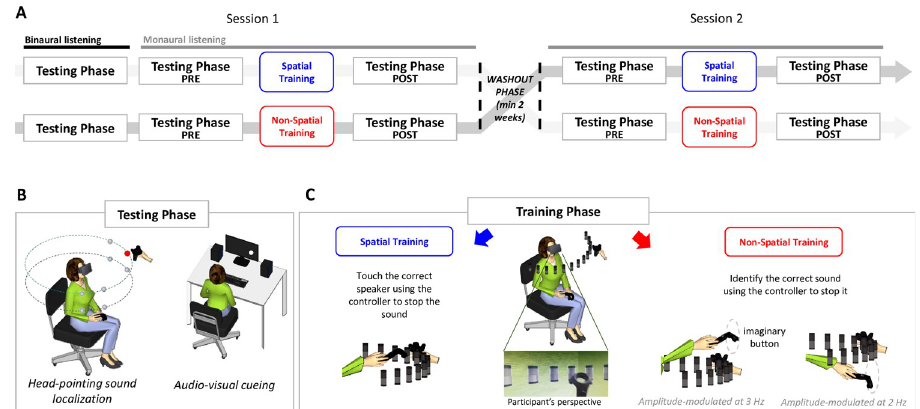
Fig 1. Experimental procedure and setting. (A) Experimental crossover protocol: all participants took part in 2 training session (session 1 and session 2). Each session was composed by two Testing phases (termed, ‘pre’ and ‘post’), separated by a Training phase (Spatial or Non-Spatial, across sessions). All phases were performed in monaural listening (i.e. with one ear plugged), but an additional testing phase at the beginning of session 1 measured performance in binaural listening. (B) Testing Phases. To the left, a schematic representation of participant wearing the HMD and holding the controller used for validation during head-pointing sound localization. The eight spheres in front of the participant indicate the pre-determined speaker positions, the loudspeaker held by the experimenter’s hand illustrates stimulation position in one example trial. To the right, a schematic representation of the setting for the audio-visual attention cueing task. (C) Training Phase. In the center, a schematic representation of participant wearing the HMD and holding the controller. Thirteen cylindrical visible speakers indicate the pre-determined positions during each of the training sessions. Below, a close-up of the scene as visible inside the HMD from participant’s perspective: during the task participant saw the virtual room, the visible speakers and the controller they held in their hand. Cartoons on either side illustrate example of the response’s movements performed during the Spatial (left) and Non-Spatial (right) training.